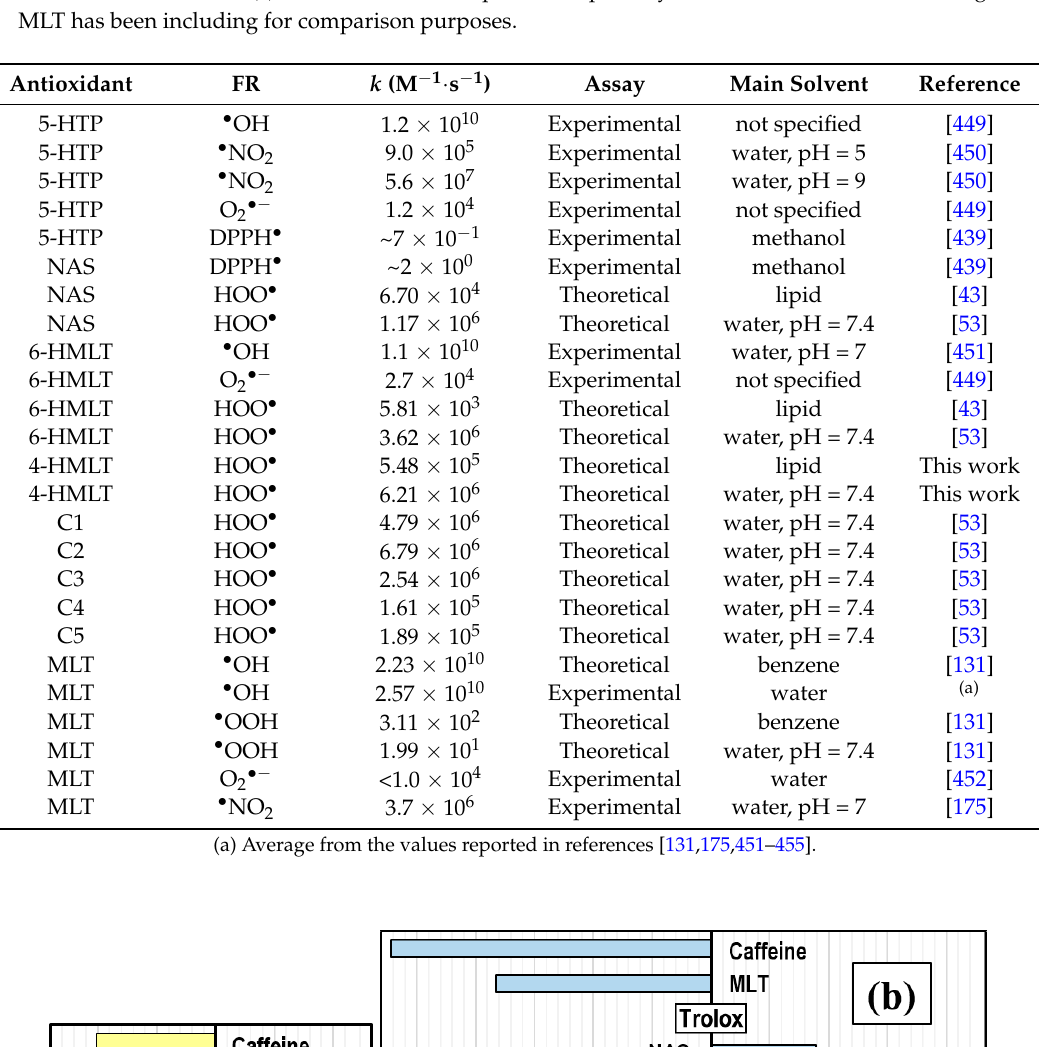
Table 3. Rate constants ( k ) of the reviewed compounds as primary antioxidants, i.e., as FR scavengers. MLT has been including for comparison purposes.